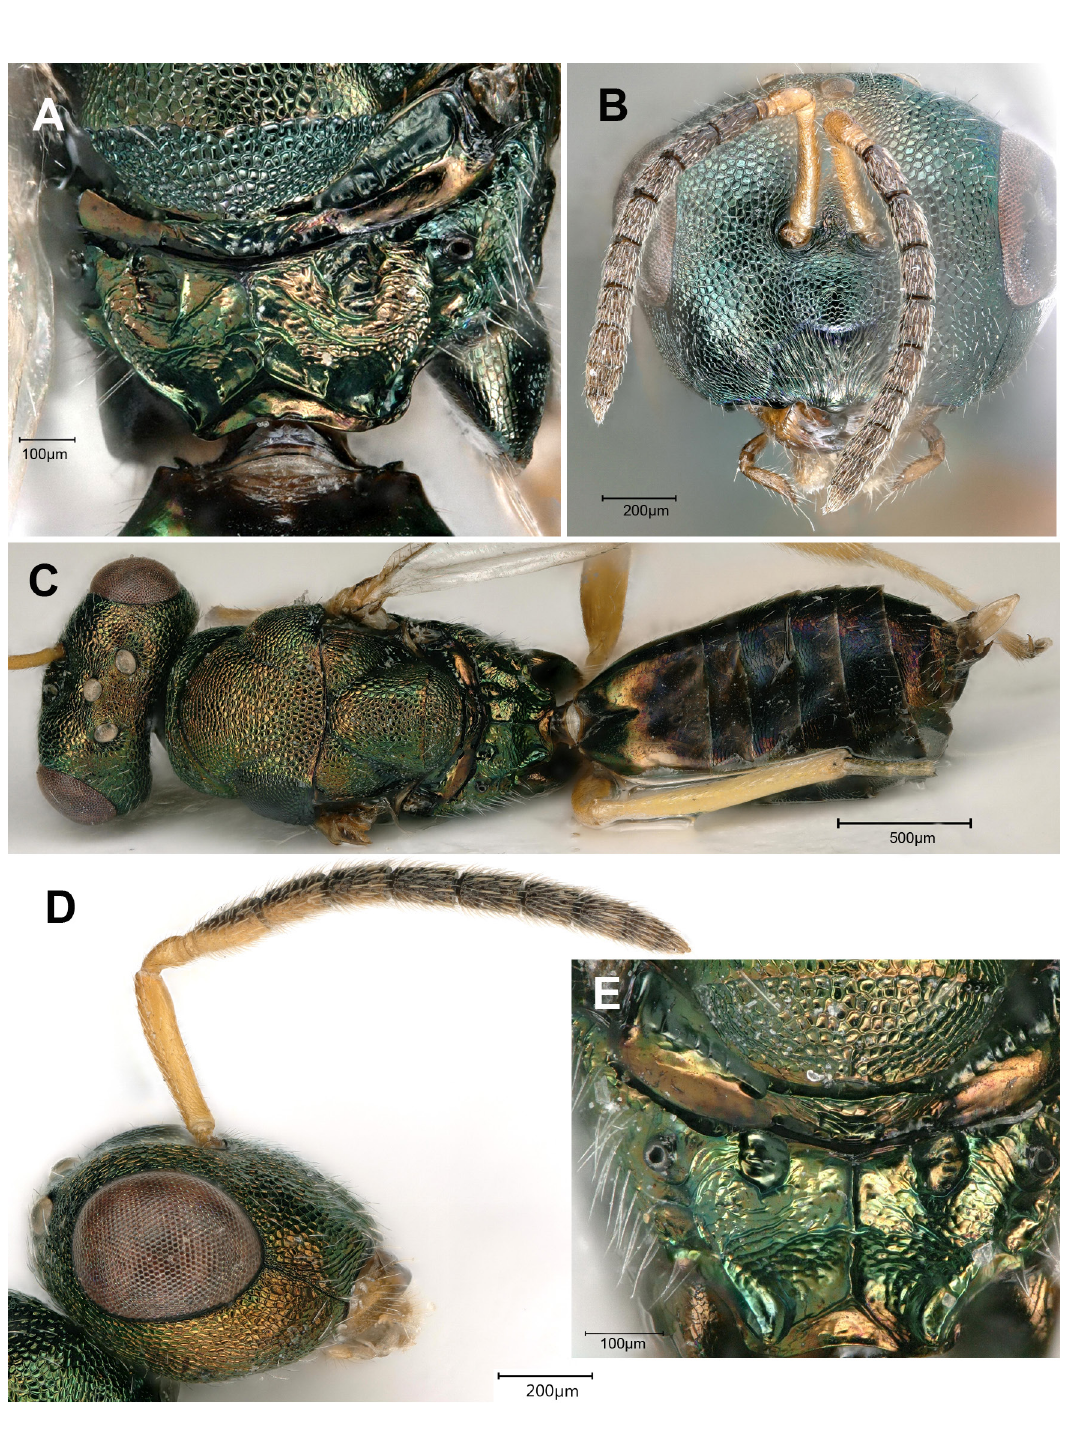
Fig. 16 . Stenomalina delvarei Lotfalizadeh & Rasplus sp. nov. A–B . Holotype, ♀ (HMIM). A . Propodeum in dorsal view. B . Head and antennae in frontal view. C–E . Paratype, ♂ (HMIM). C . Dorsal view. D . Head and antenna in lateral view. E . Propodeum in dorsal